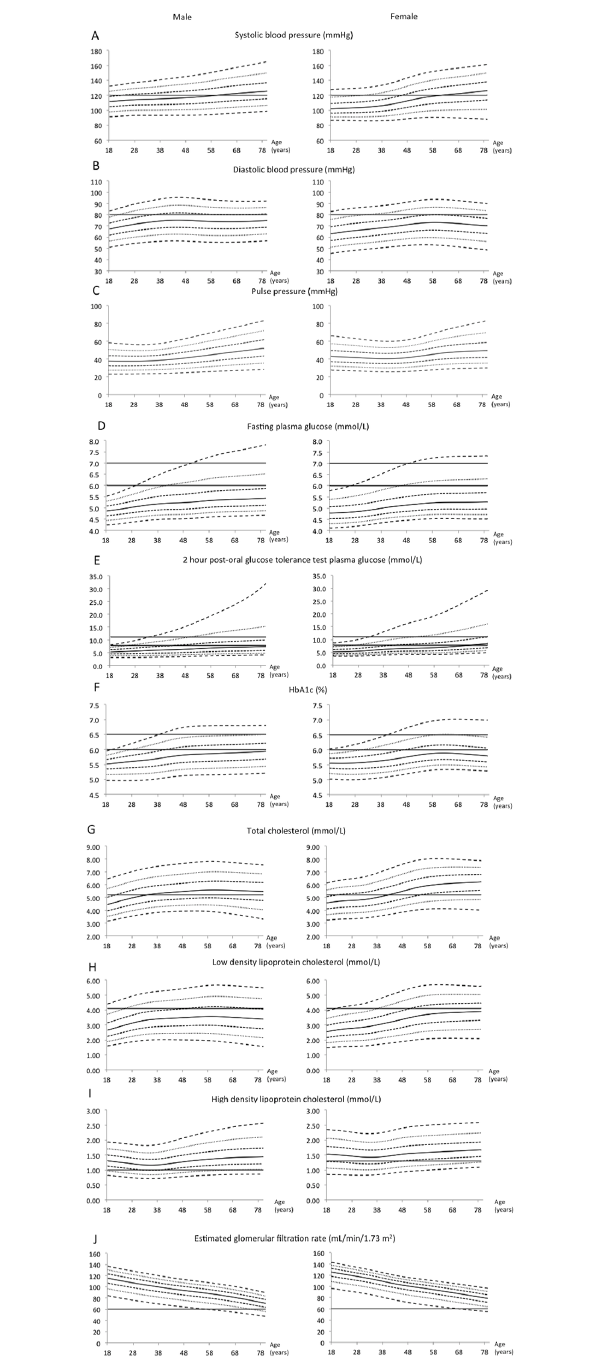
Fig 1. Centile charts of cardiometabolic parameters of subjects who participated in the Singapore National Health Survey 2010 and had no history of chronic illnesses. The broken lines represent (from bottom to top), the 3rd, 10th, 25th, 50th, 75th, 90th, 97th percentile lines of the survey population. The solid horizontal lines represent limits of normality or desired targets.